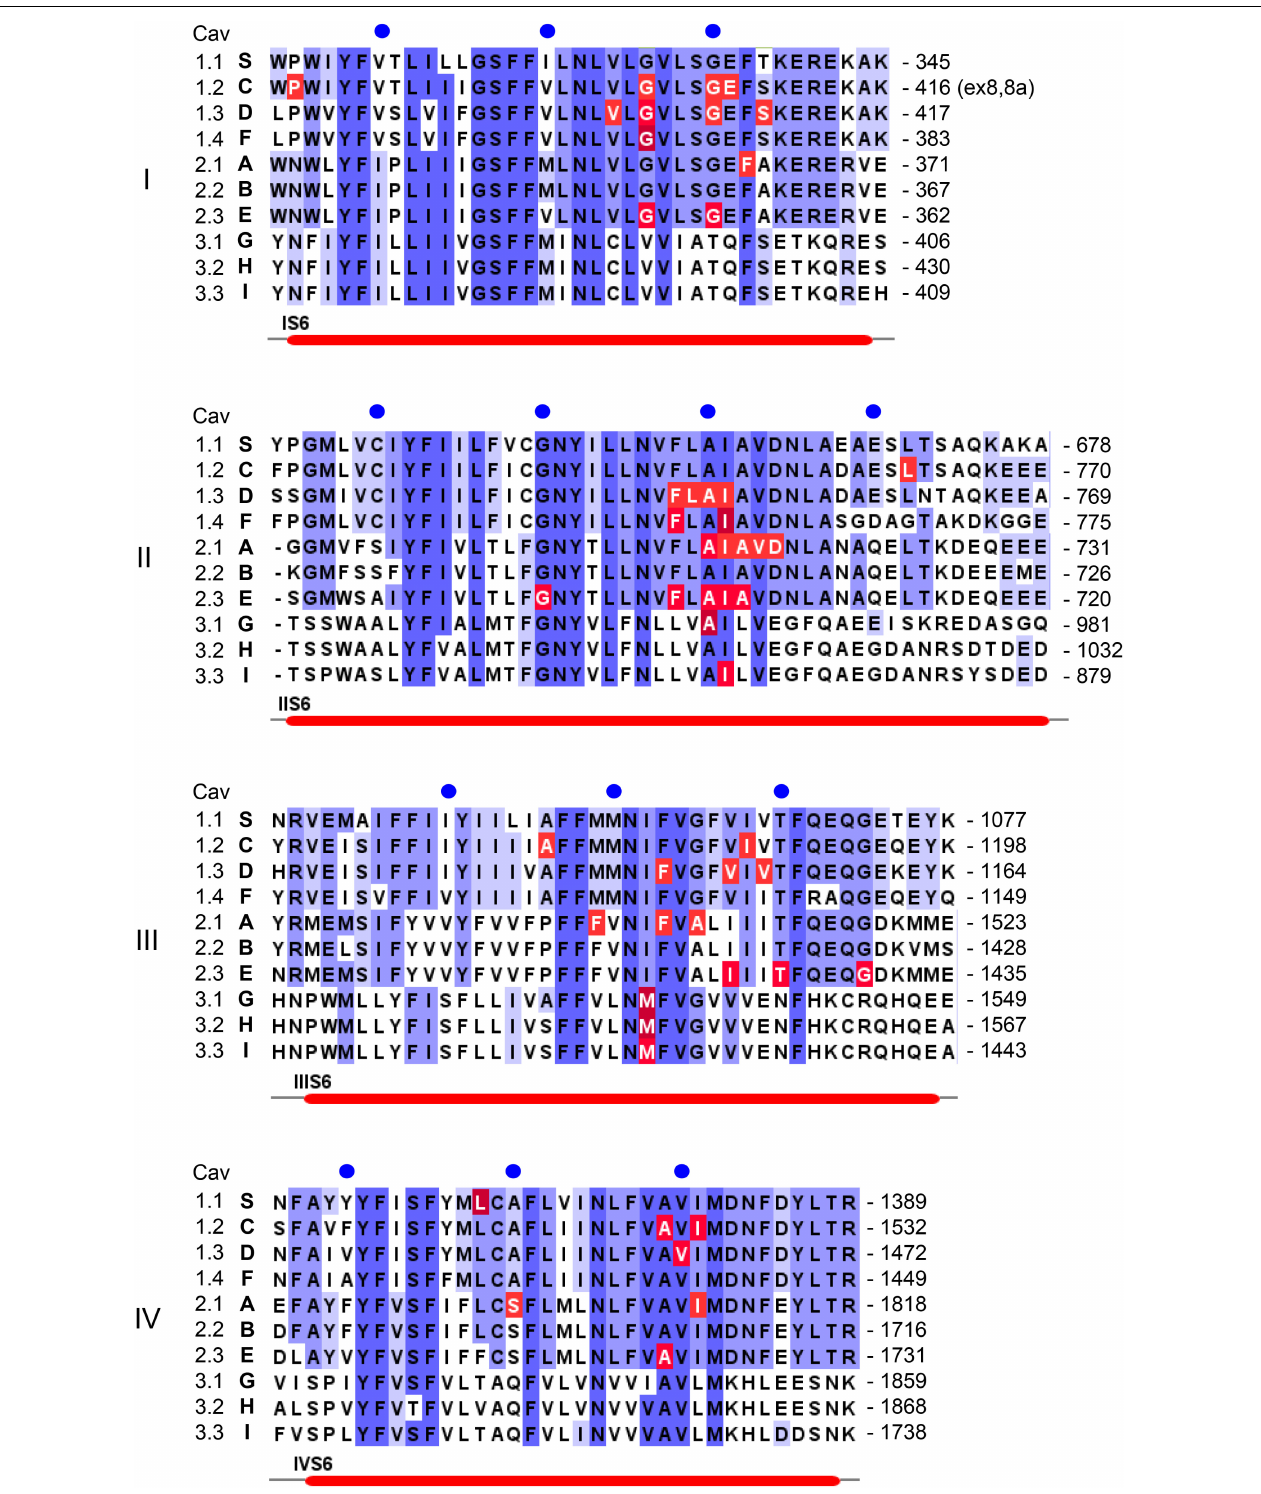
FIGURE 3 | Position of pathogenic mutations within S6 helices of the ten different Ca 2 + channel α 1-subunits. Sequence alignment and labeling is as described in legend to Figure 4 .